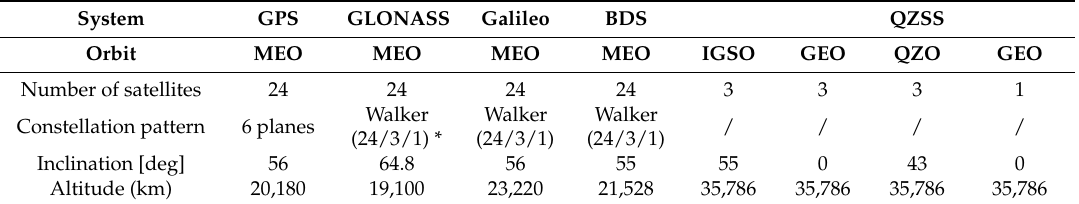
Table 3. The configurations for the five nominal Global Navigation Satellite System (GNSS)